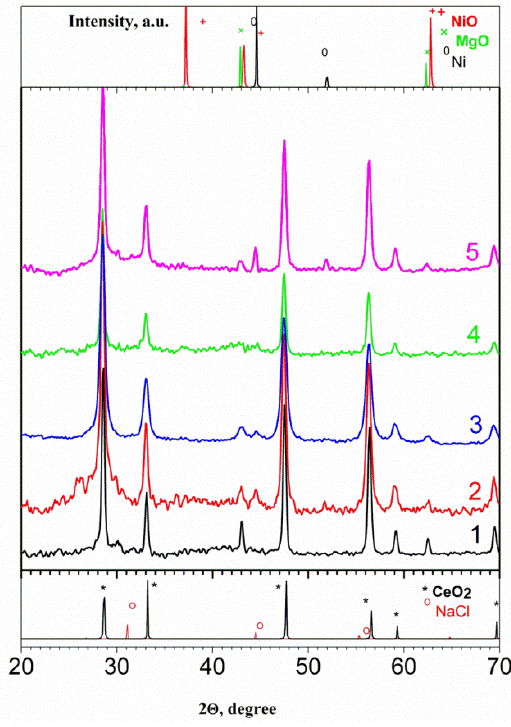
Figure 3. X-ray diffraction patterns of the catalysts reduced at 800 °C. 1—Ni/CeMg-C-S-O; 2— Ni/CeMg-A-S-V; 3—Ni/CeMg-A-S-O; 4—Ni-Pd/CeMg-A-S-V; 5—Ni/CeMg-A-P-O. Table 3. Influence of the reduction temperature on the phase composition and dispersion of